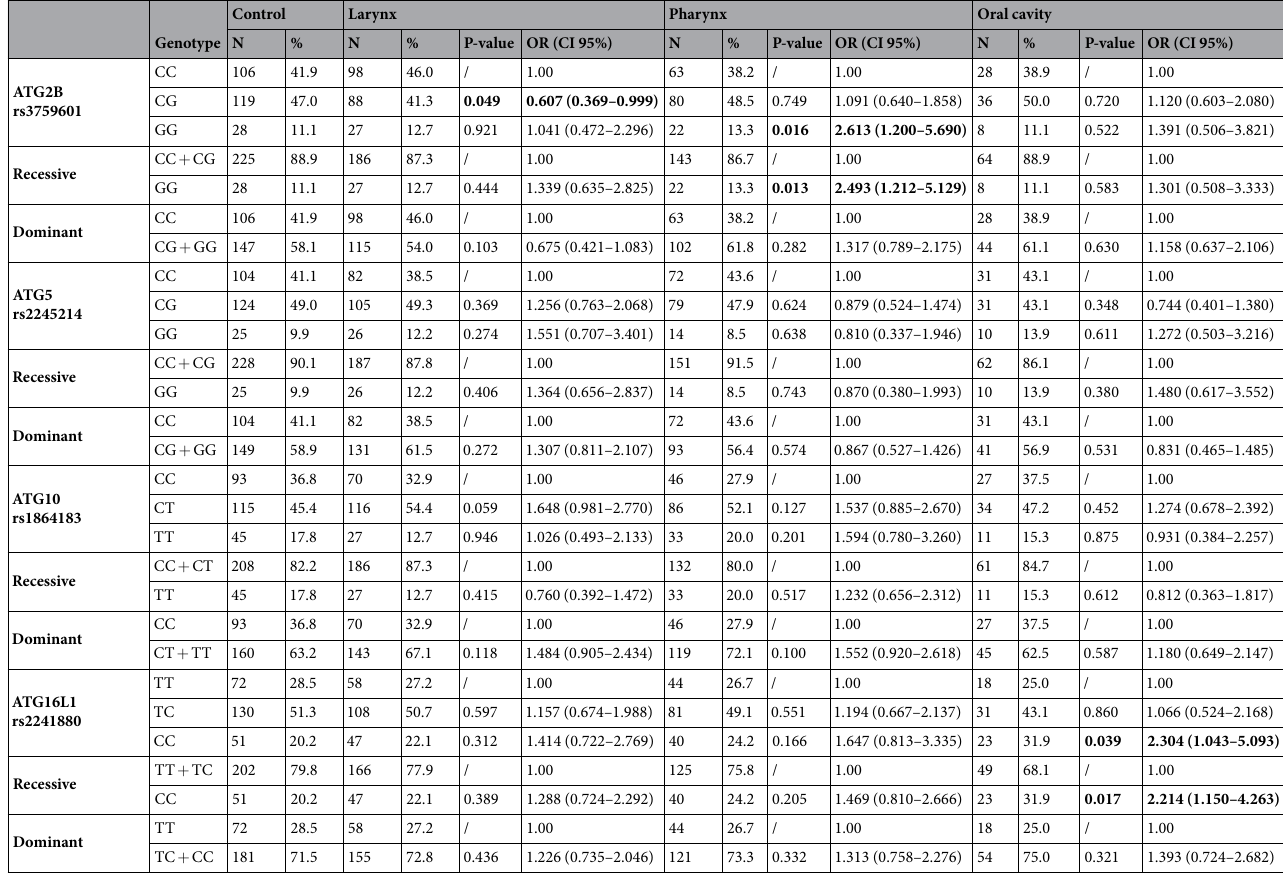
Table 3. Comparative results in selected ATG polymorphism distribution in laryngeal, pharyngeal